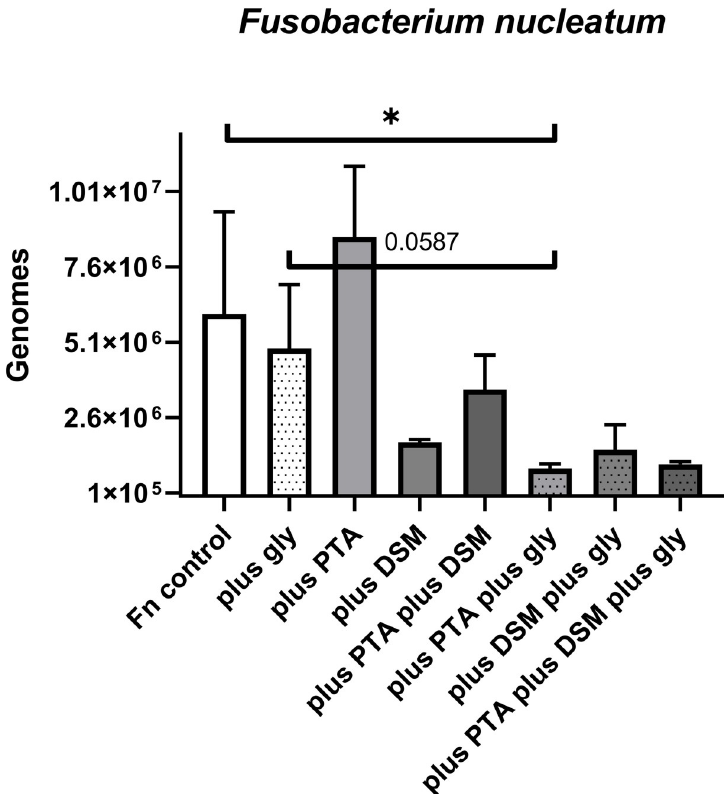
Level of significance � p < .05. Abbreviations: Fn ( Fusobacterium nucleatum ), PTA ( Lactobacillus reuteri ATCC PTA 5289), DSM ( Lactobacillus reuteri DSM 17938), gly